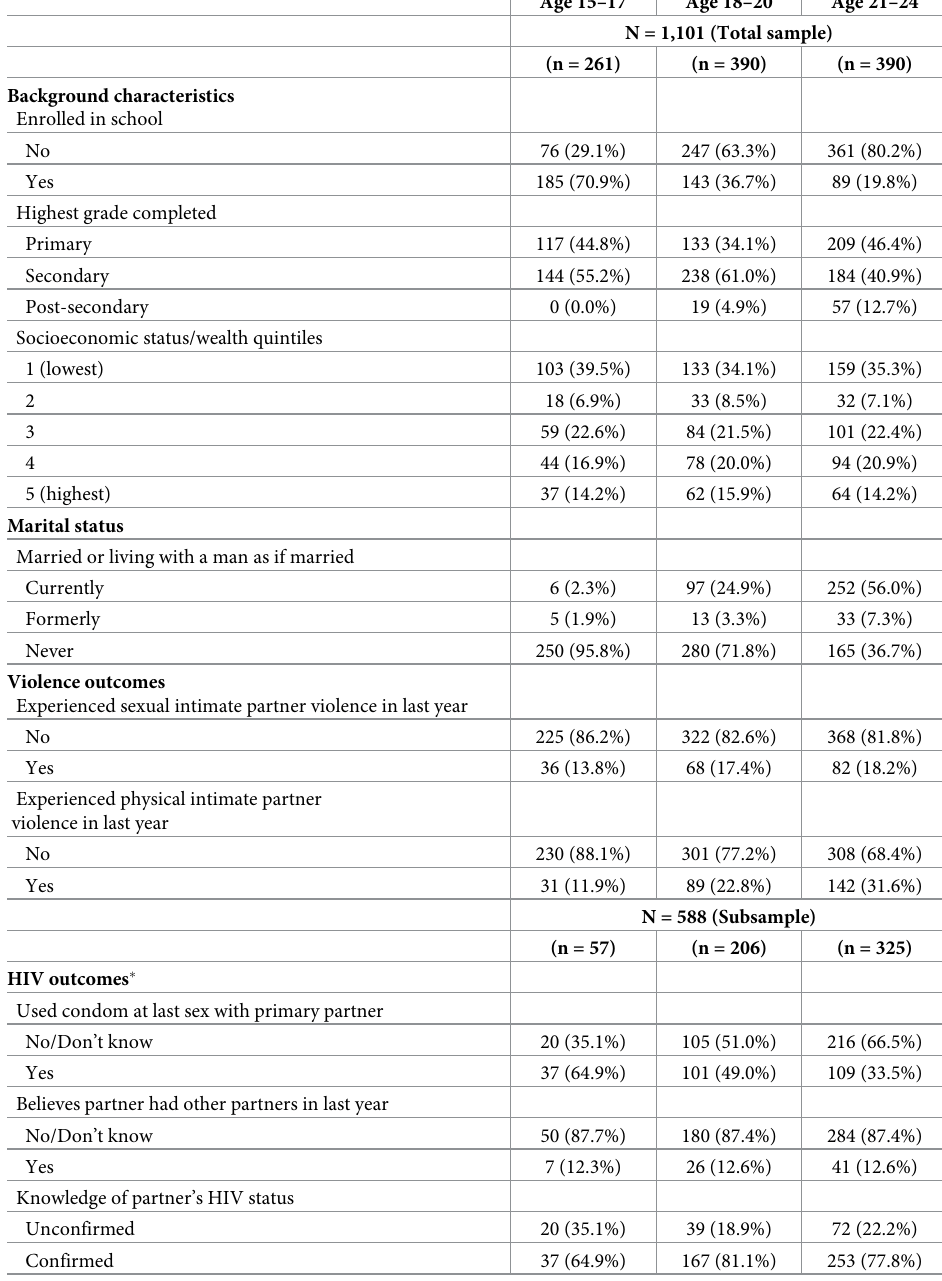
Table 1. Respondent background characteristics, HIV risk, and experiences of